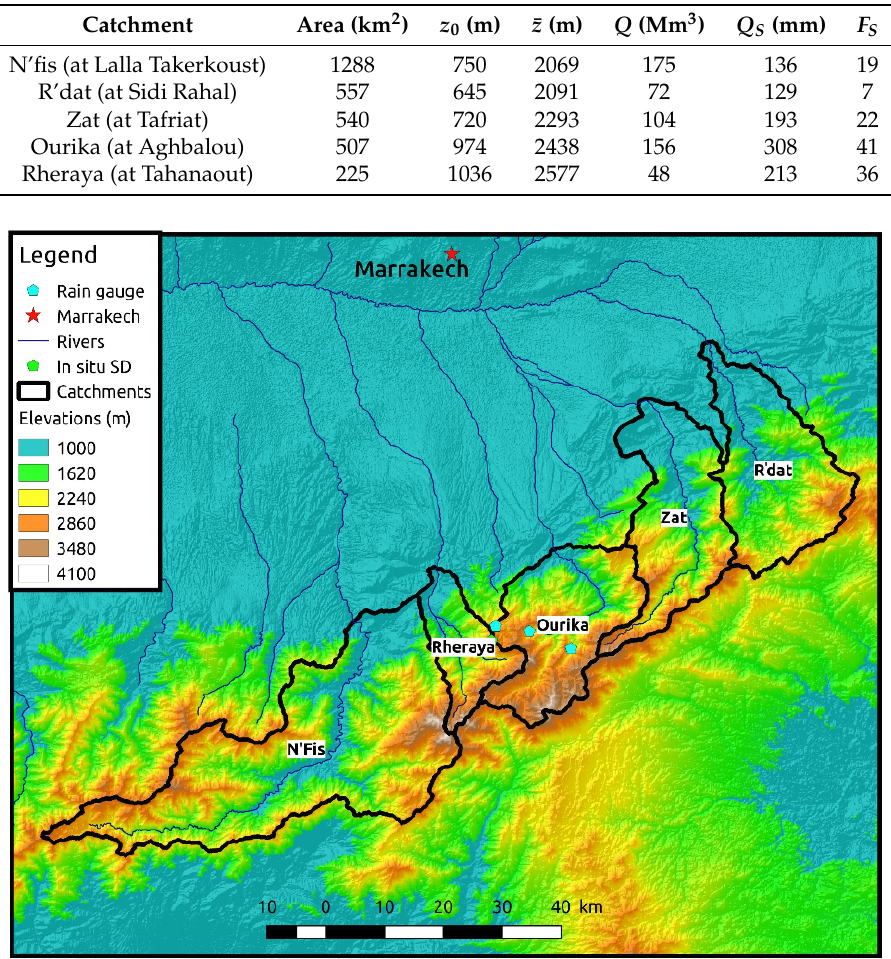
Figure 1. Location of the catchments of the five main tributaries of the Tensift River in the High Atlas. SD: Oukaimeden station snow depth